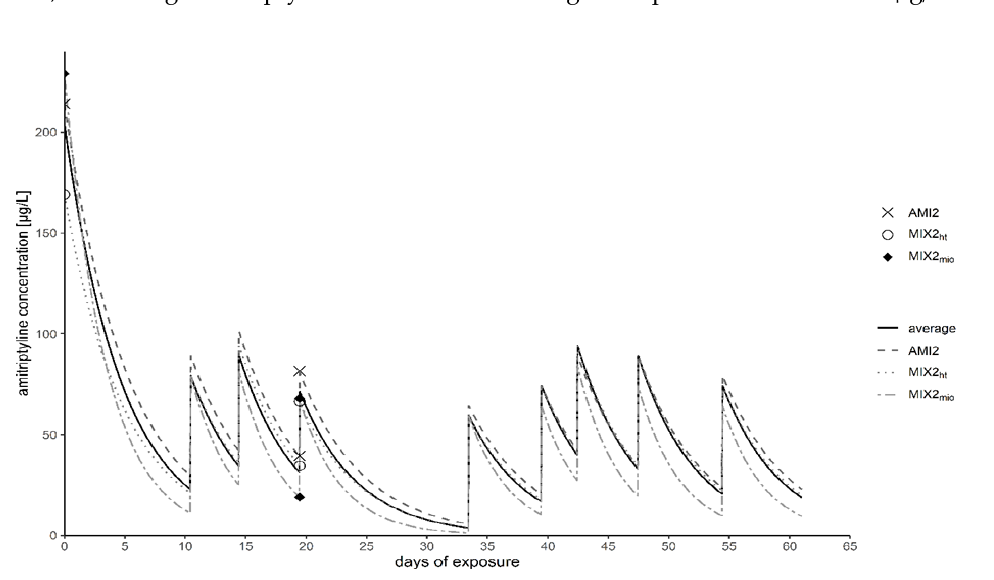
Figure 3. Modelled amitriptyline concentration over the duration of the experiment. Measured concentrations of the three exposure groups (AMI2, MIX2 ht , and MIX2 mio ) are depicted as